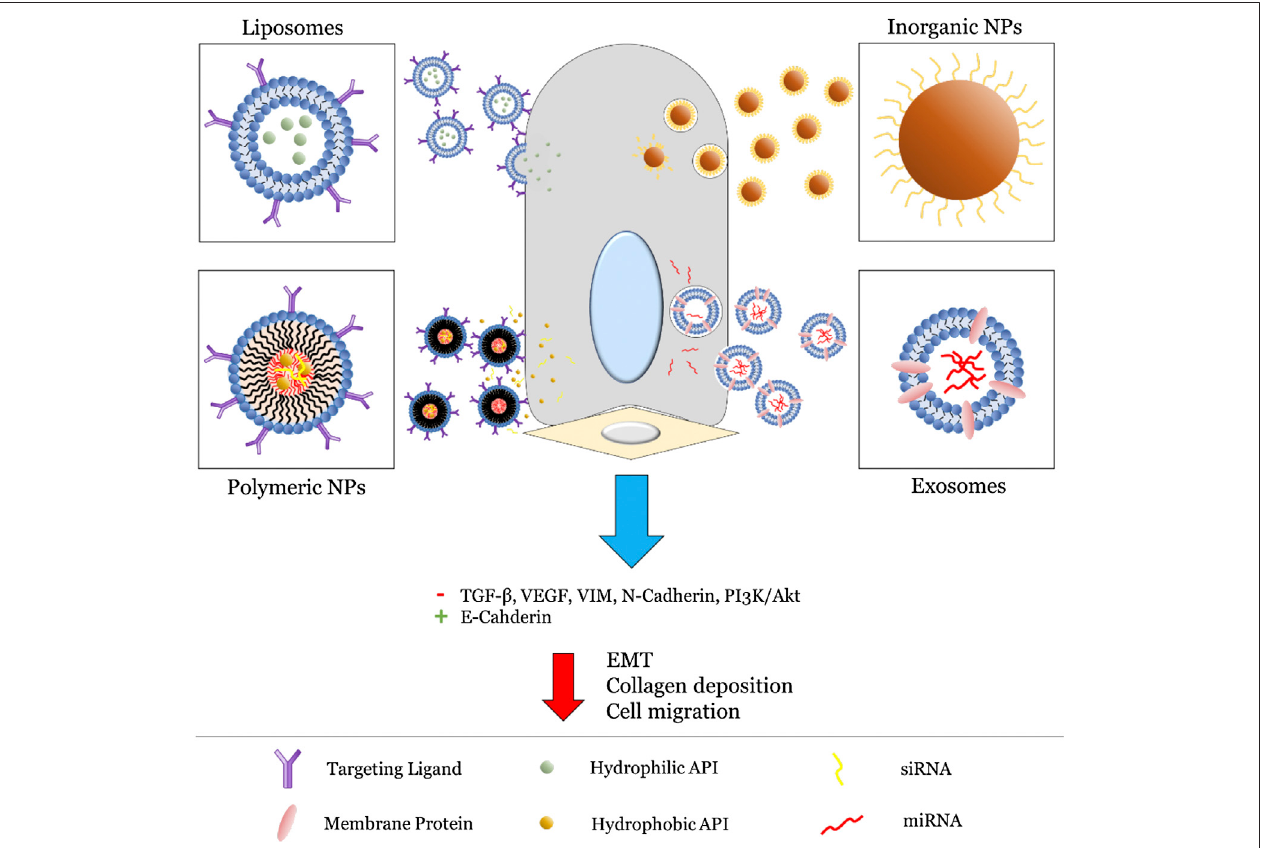
FIGURE3| General strategies utilizedfor NP(liposomes, polymericNPs,inorganic NPs,and exosomes)targetingtheEMTpathway.Forliposomesand polymeric NPs, this primarily involves active targeting via surface-bound ligands (typically proteins) followed by release of an encapsulated API. On the other hand, inorganic NPs andexosomesinvolveinnateinhibitionviatheirintrinsicphysiochemicalproperties.Altogether,thisleadstoinhibitionofkeyEMTbiomarkersandsubsequentreductionin fi brosis.